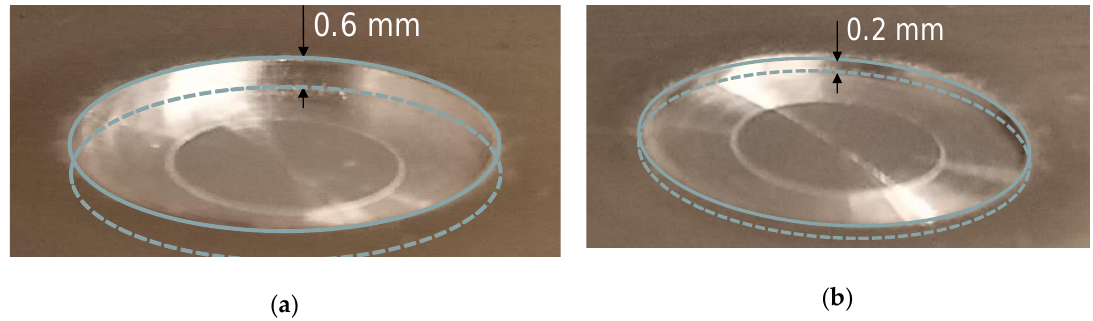
Figure 10. Surface dents in the weld crown: ( a ) 0.6 mm dent in a 1D-edge-margin panel; ( b ) 0.2 mm dent in a 2D-edge-margin panel.